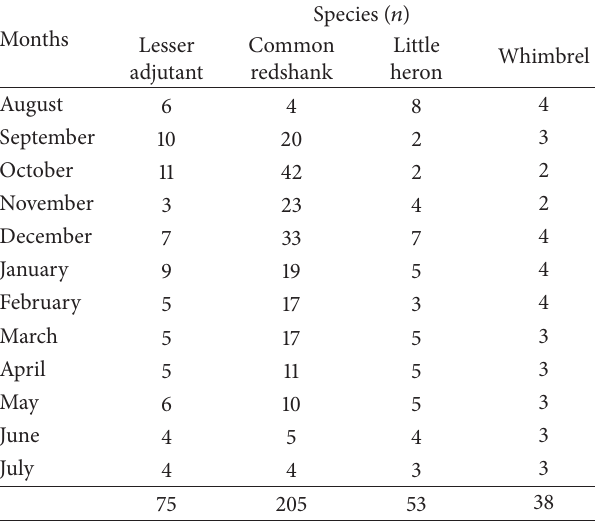
Table2:Summaryoffrequencyofindividualofshorebirdandwater bird species observed ( 𝑛 ) from August 2013 until July